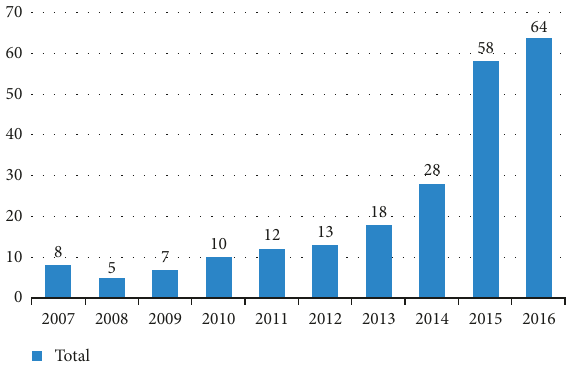
Figure 1: Number of CRTimplantations per million inhabitants in Croatia in the last